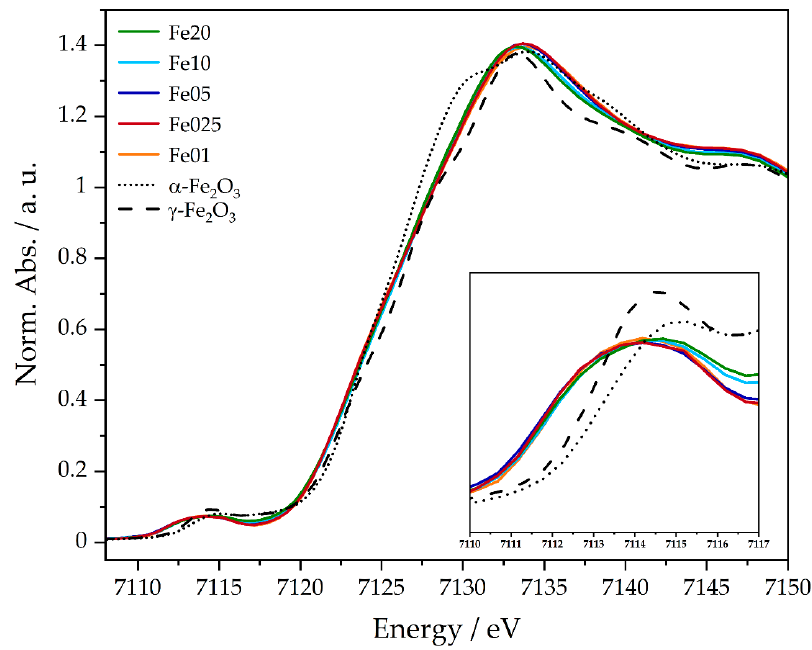
Figure 10. XANES spectra of Fe01 to Fe20 and the respective references α - and γ -Fe 2 O 3 at the Fe K-edge.